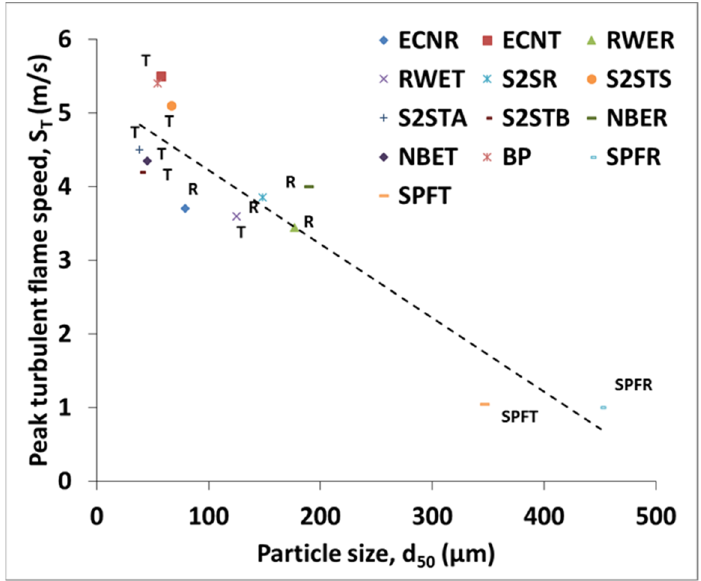
Figure 7. Maximum turbulent flame speed (ST, max) vs. average size for 50% fraction (d50) for present samples in comparison to other results of raw (R) and thermally treated samples (T) [30,39,42,58,59].